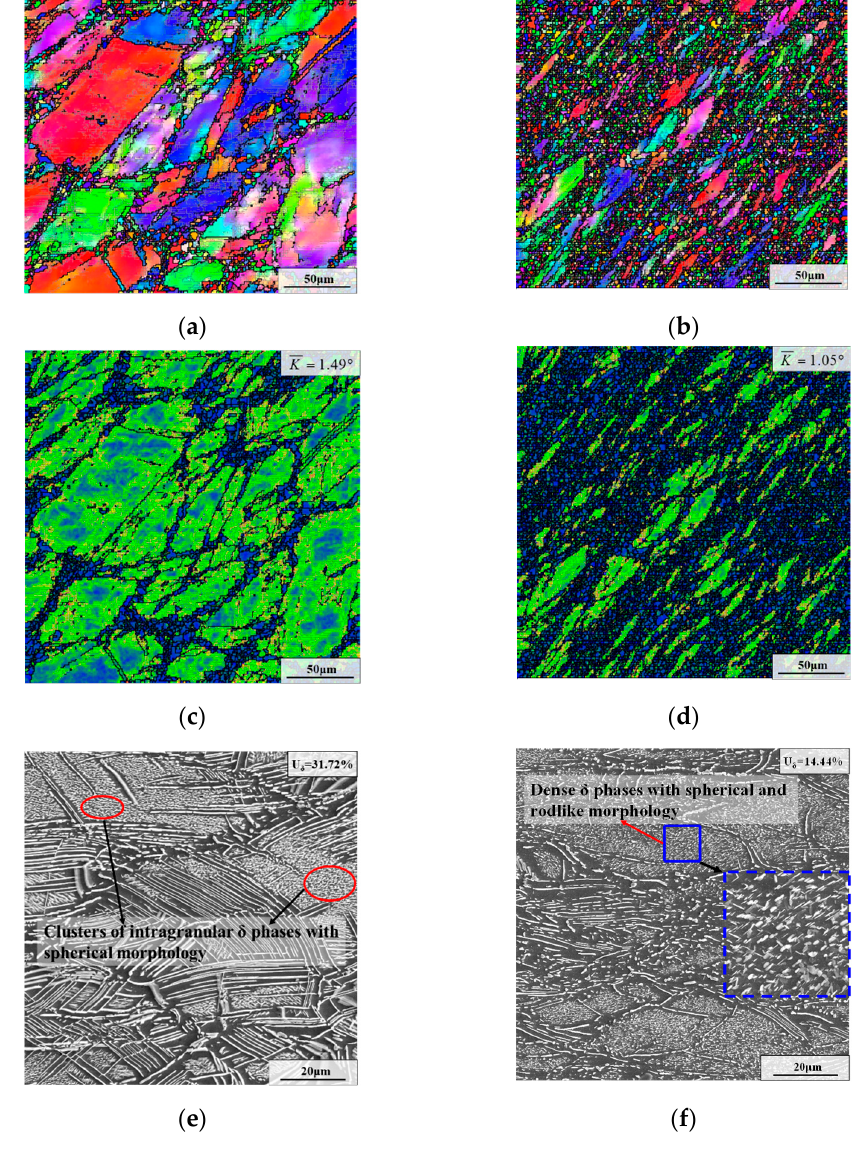
Figure 9. Deformed microstructures after the first annealing stage with different true strains: ( a , c , e ) 0.36; ( b , d , f ) 1.20. (The deformation temperature is 950 °C, and the strain rate is 0.1 s − 1 ).